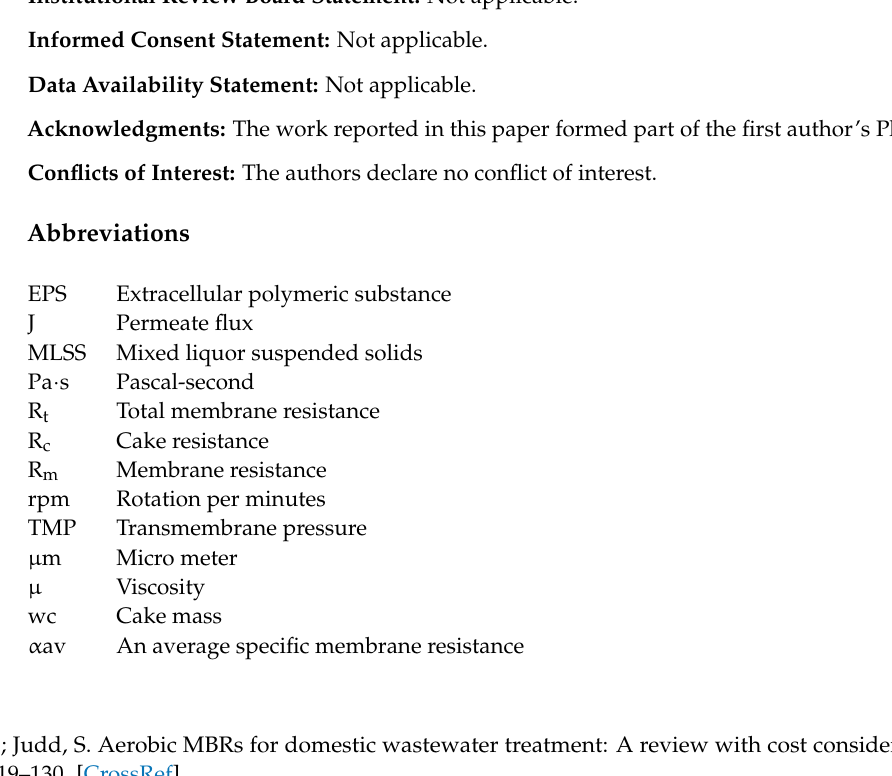
Figure S2: Effect of viscosity on cake resistance under various air flow rates at 15 L/m 2 /h, (Kaolin clay concentration = 10 g/L); Figure S3: Effect of viscosity on particle deposition under various air flow rates at 10 L/m 2 /h; Figure S4: Effect of viscosity on particle deposition at a permeate flux of 15 L/m 2